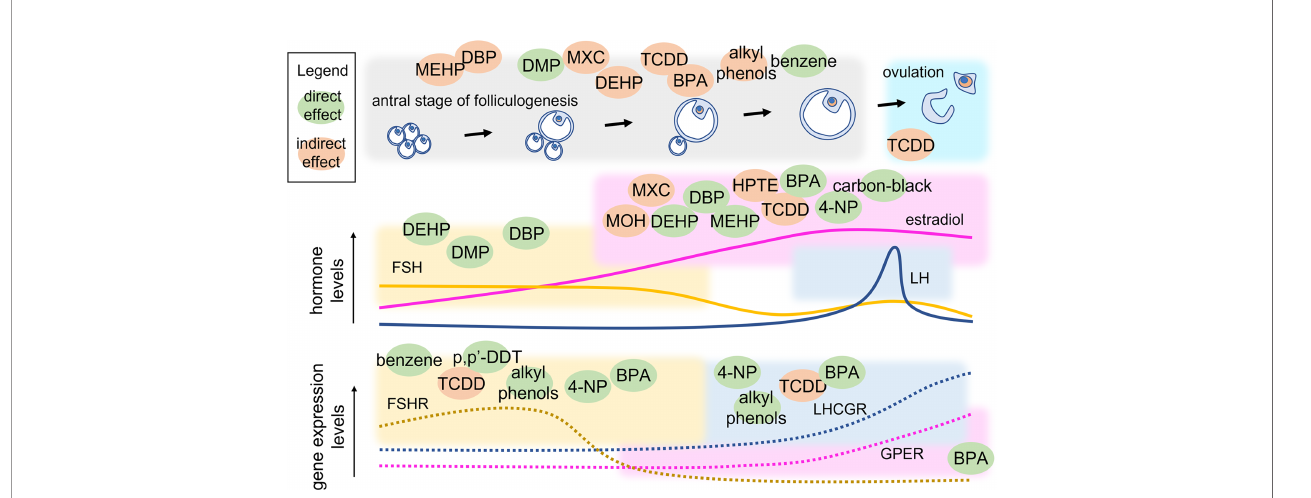
FIGURE 3 | Point of action of EDs in the antral stage of folliculogenesis. Variations of hormone and receptor expression levels are shown together with follicle growth. EDs are located within coloured squares indicating the endpoint that they may modulate directly (green) or indirectly (orange). MEHP, mono(2-ethylhexyl) phthalate; DEHP, di(2-ethylhexyl) phthalate; DBP, dibutyl phthalate; DMP, dimethyl phthalate; MXC, Methoxychlor; TCDD, 2,3,7,8-Tetrachlorodibenzo-p-Dioxin; BPA, bisphenol A; 4-NP, 4-Nonylphenol; p ’ p-DDT, methoxychlor, dichlorodiphenyltrichloroethane; MOH, 1,1,1-trichloro-2-(4-hydroxyphenyl)-2-(4-methoxyphenyl) ethane; HPTE,